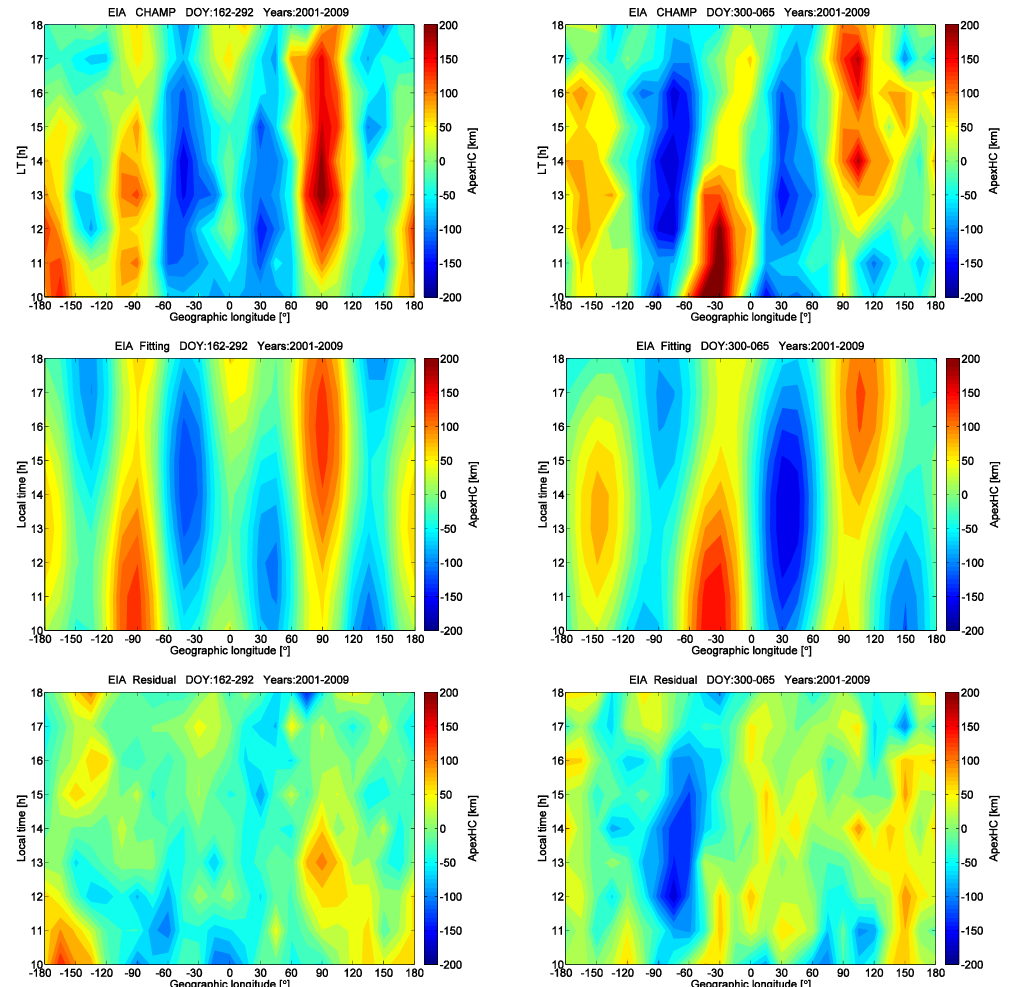
Fig. 6. The local time versus longitudinal distribution of ApexHC, observations (top), synthetic signals (middle) and residual (bottom) during the months around August (left) and December solstice (right).